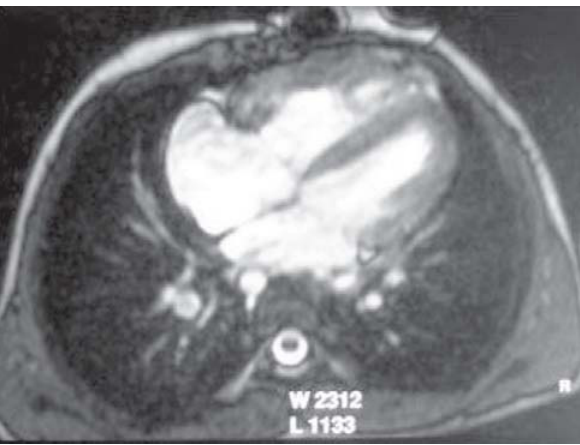
Fig. 1 - Angiorressonância nuclear magnética mostrando as quatro câmaras